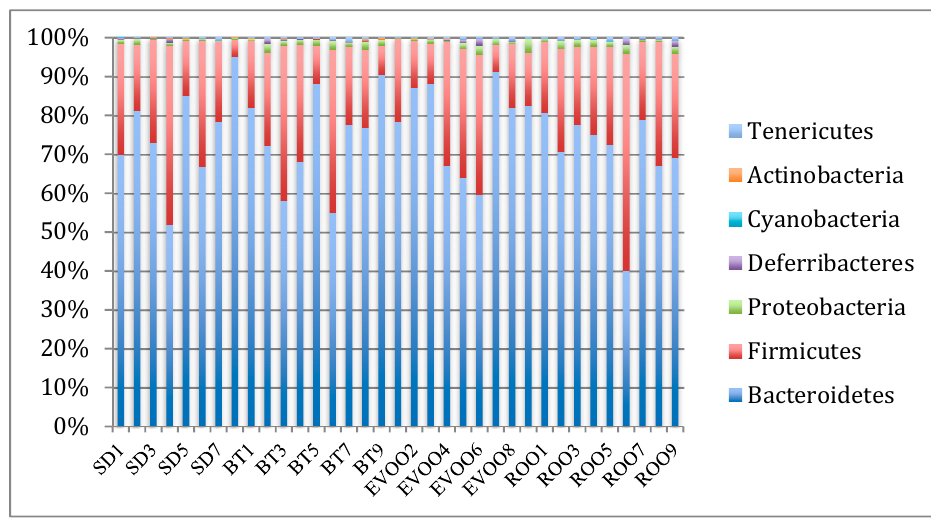
Figure 1. Bacterial distribution, in sequence percentage, at the level of phylum. Each column represents the bacterial fecal community from one mouse, grouped by diet. BT: butter diet; EVOO: extra virgin olive oil diet; ROO: refined olive oil diet; SD: standard chow. SD, EVOO, and BT diet values from Prieto et al. [12].